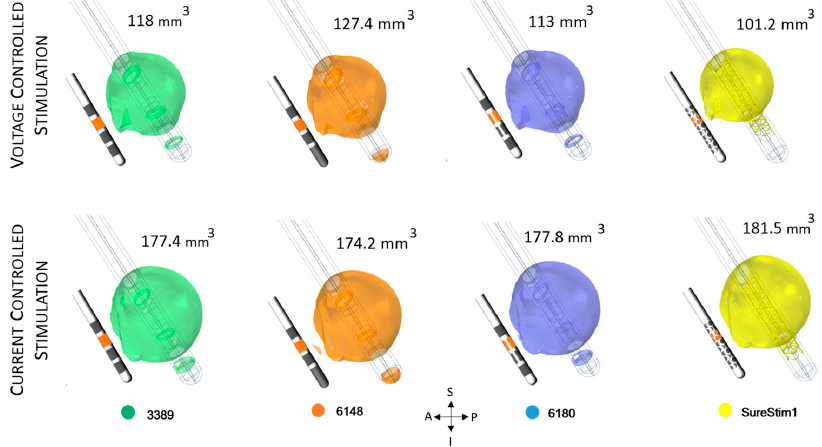
Figure 7. Electric field (EF) simulated at ZI for each lead depicted with an isosurface of 0.2 V/mm. Active contacts (shown in orange in each lead schematic) set to 3 V (first row) and 3.4 mA (bottom row). EF volume within the selected isosurface shown to the right of the lead. A: anterior, P: posterior, S: superior, I: inferior, L: left, R: right.